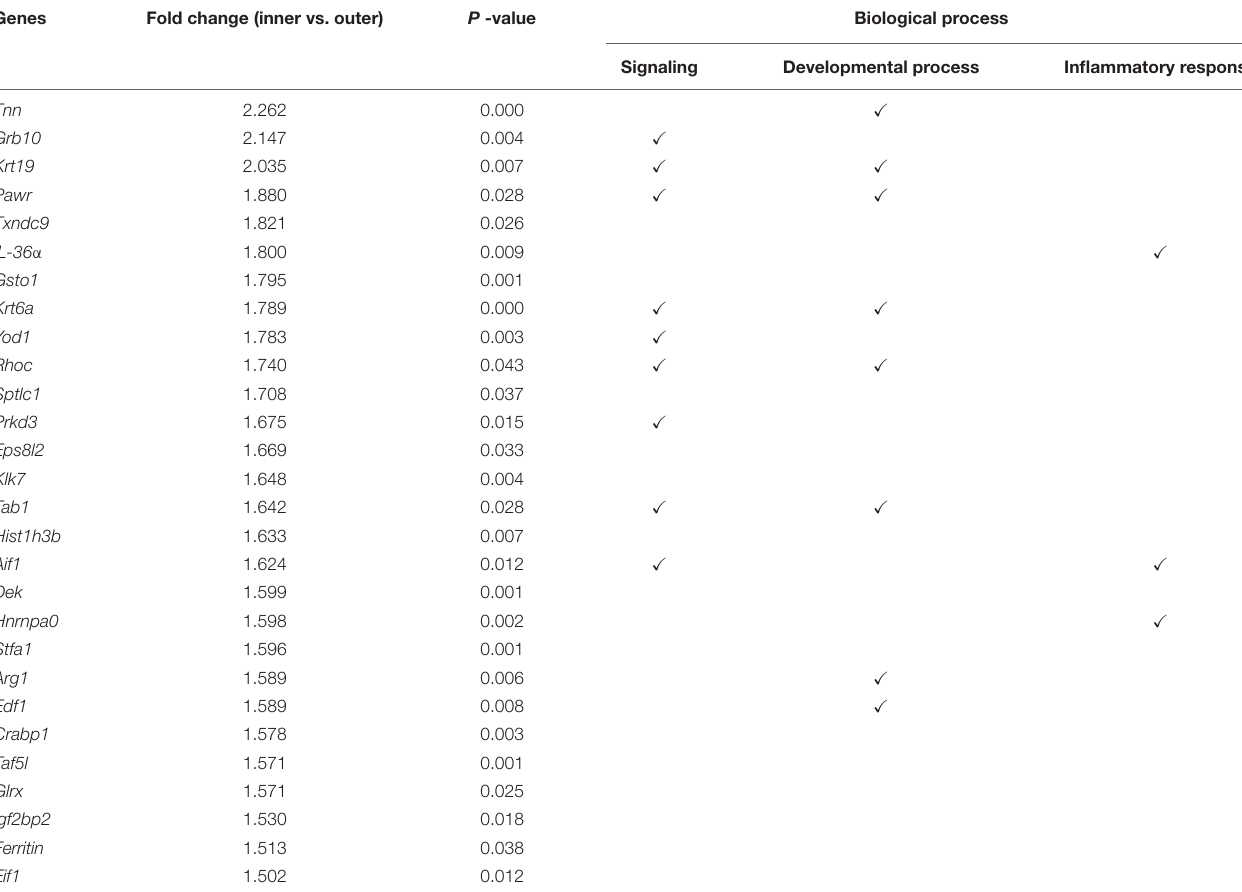
TABLE 1 | Proteomic analysis showing 28 upregulated proteins in the inner area ( de novo hair follicle growth area) that are involved in biological regulation. Genes Fold change (inner vs. outer) P -value Biological process